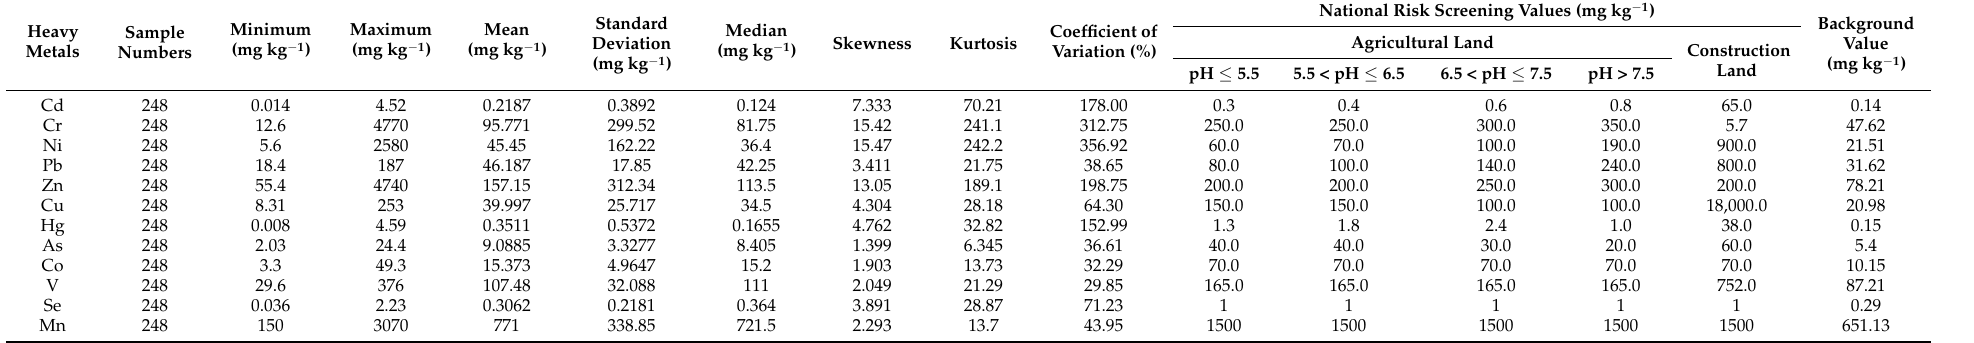
Table 2. Descriptive statistics of the 12 soil heavy metals in the study